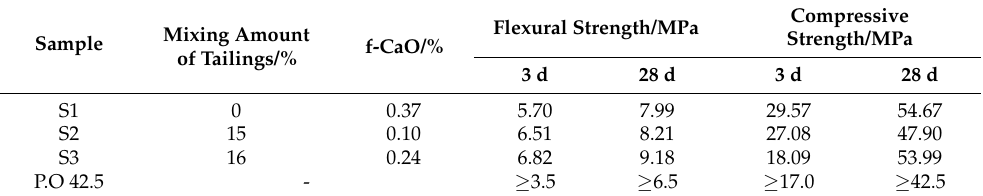
Table 2. Performance comparison of cement clinker with different tailings content